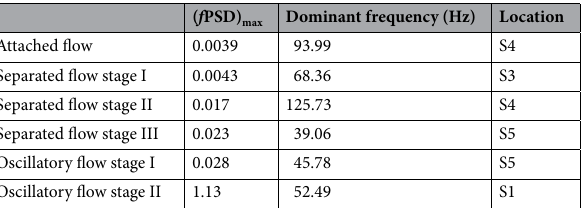
Table 3. Spectral evolution of pressure fluctuations on suction surface during throttling